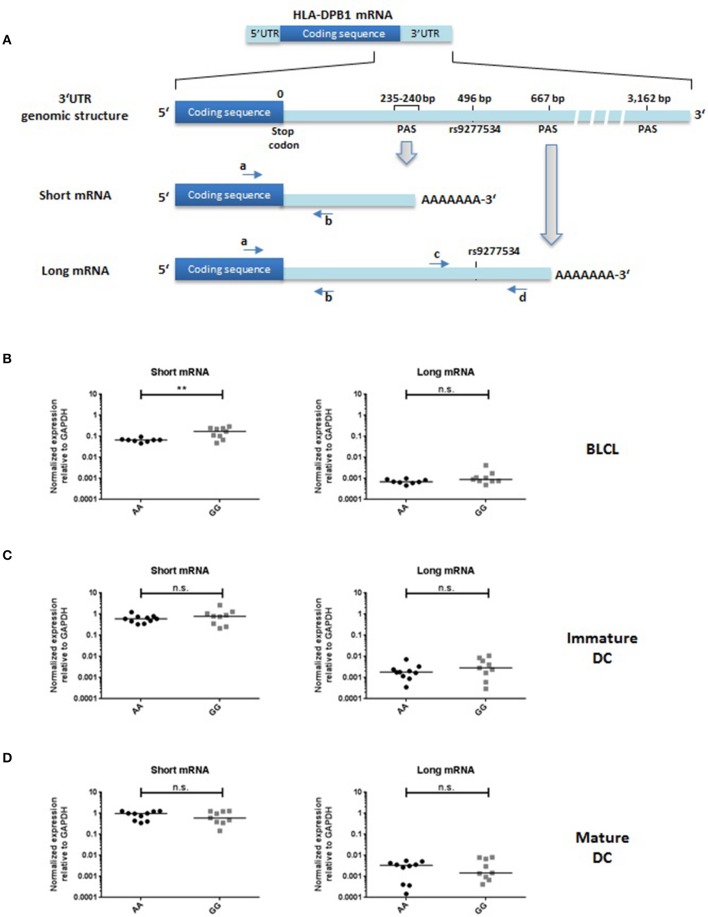
HLA-DPB1 transcriptional expression in relation with rs9277534 SNP in BLCL and DC. (A) Schematic representation of the HLA-DPB1 genomic structure and a short and long form of mRNA generated by two different polyadenylation sites (PAS) about 400 bp apart, as reported in the GenBank database (ID: NM_002121.5). Note that the long but not the short mRNA includes the rs9277534 SNP. Primer locations for qPCR quantification of both transcripts are indicated as arrows a-b or c-d (see also Table 3). Primers “a” and “b” anneal to both the short and the long mRNA, while primers “c” and “d” are specific for the long mRNA. (B–D) Short (left panel) and long (right panel) HLA-DPB1 mRNA was quantified in BLCL (N = 17, B), immature DC (N = 20, C) and mature DC (N = 20, D), by qPCR relative to GAPDH as described in Materials and Methods. Cells were homozygous for either rs9277534-A/A (AA) or rs9277534-G/G (GG) (Tables 1,2). Statistical comparisons were performed by the two-tailed unpaired t-test (n.s. not significant; **p < 0.01).